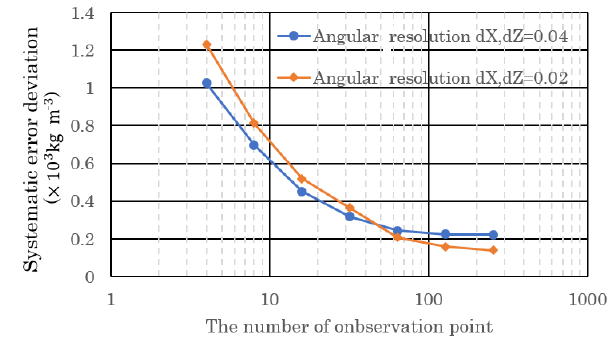
Figure 6. The relationship between the number of observation points and the systematic error deviation σ sys